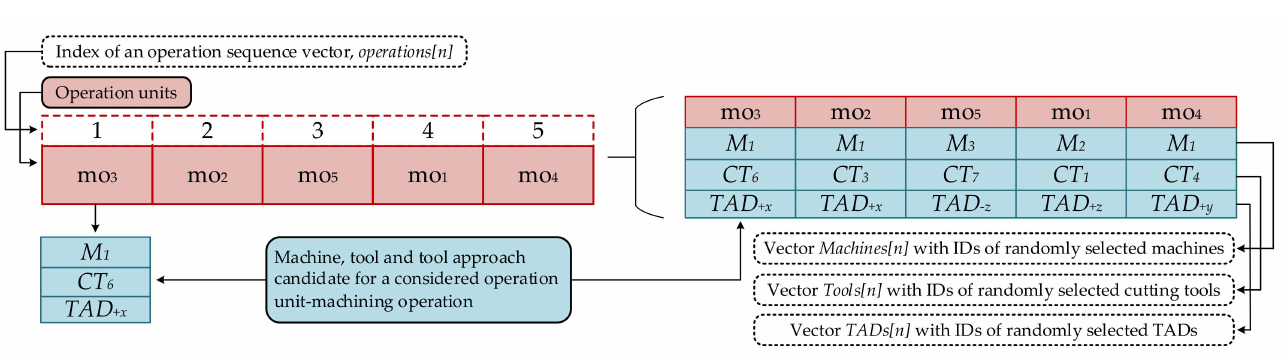
Figure 1. Process plan